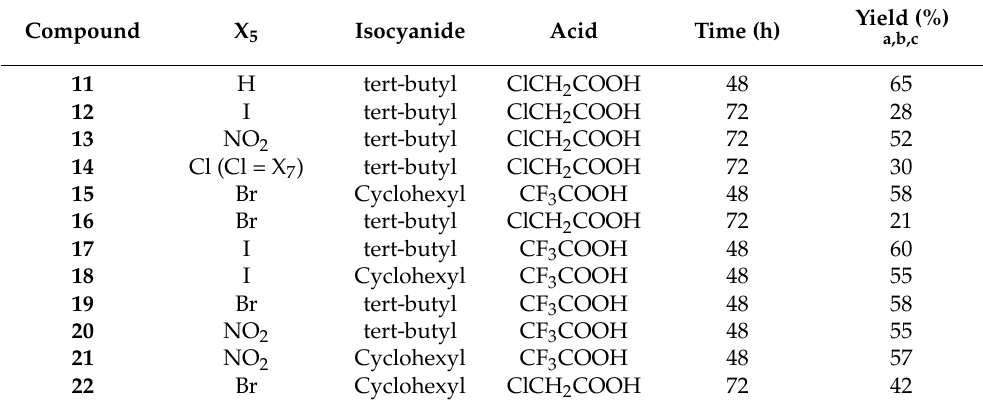
a Yield after purification. b All reactions used n-butylamine as the amino component, molecular sieves 3Å , rt. c All reactions were treated with Capsule@Amberlyst-15 for isocyanide scavenging.